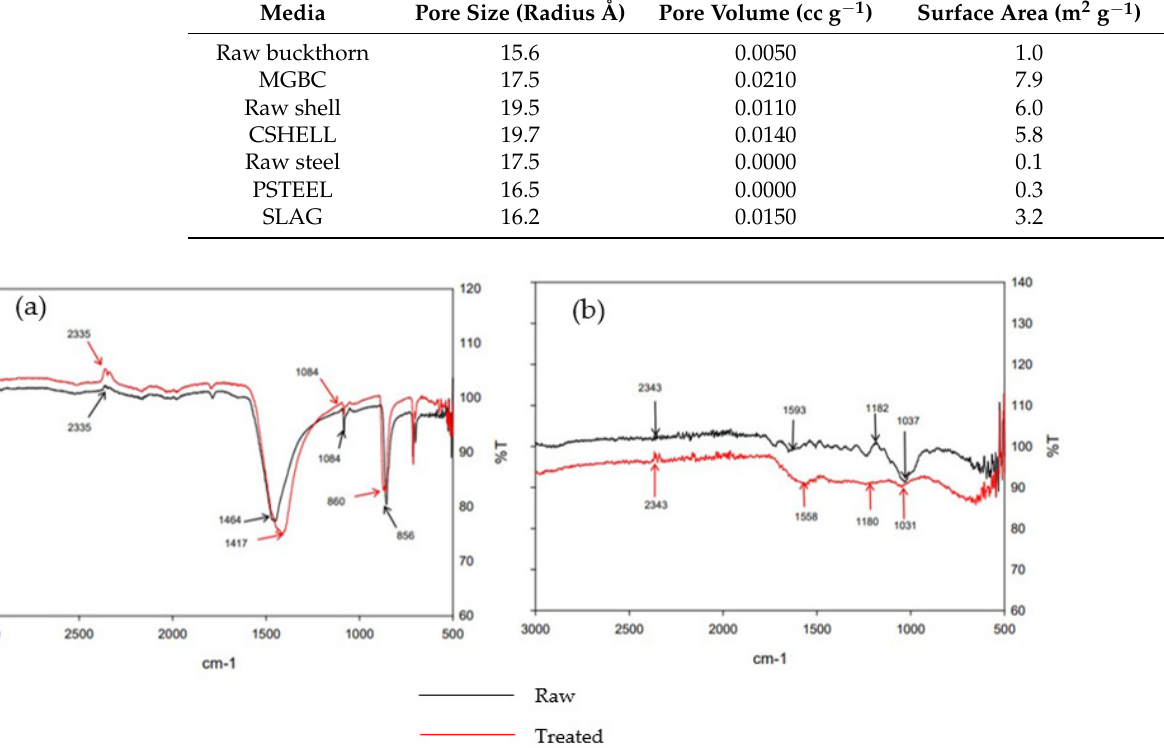
Figure 2. FTIR graphs showing the difference in raw and treated samples: ( a ) CSHELL; ( b ) MGBC.